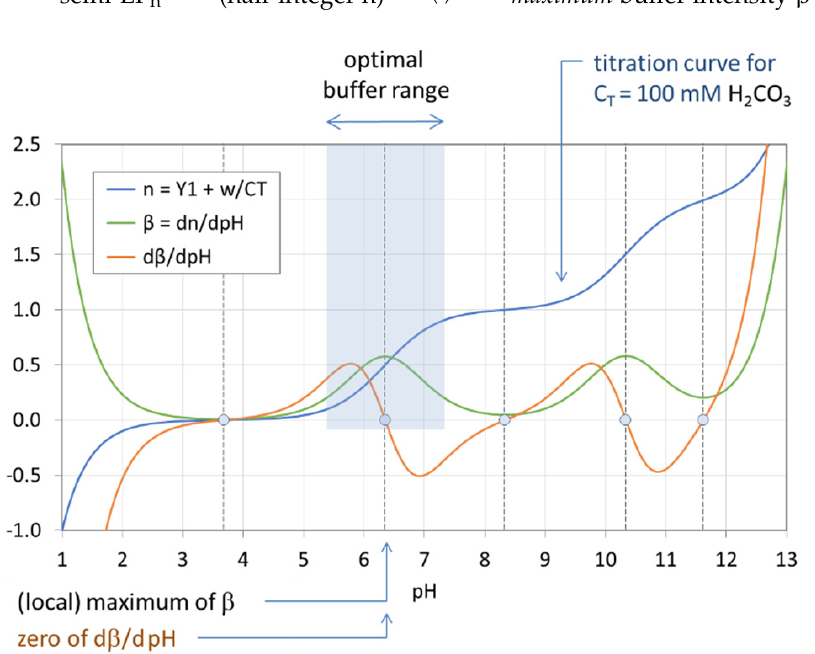
Figure 18. Optimal buffer range of the H 2 CO 3 system with C T = 100 mM.